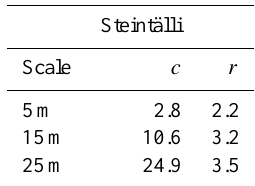
Fig. 8. (a–c) Smoothing factor F and (d–f) coefficient of determination R 2 ( p < 0.0001) between snow surface roughness and terrain Fig. 8: (a–c) Smoothing factor F and (d–f) coefficient of determination R 2 (p < 0.0001) between snow surface roughness and roughness as a function of scale for the basins ST, CB1 and CB2. terrain roughness as a function of scale for the basins ST, CB1 and CB2. Table 3. Coefficients c and r of the power function modelling ter- rain smoothing (Eq. 16) in the basin of